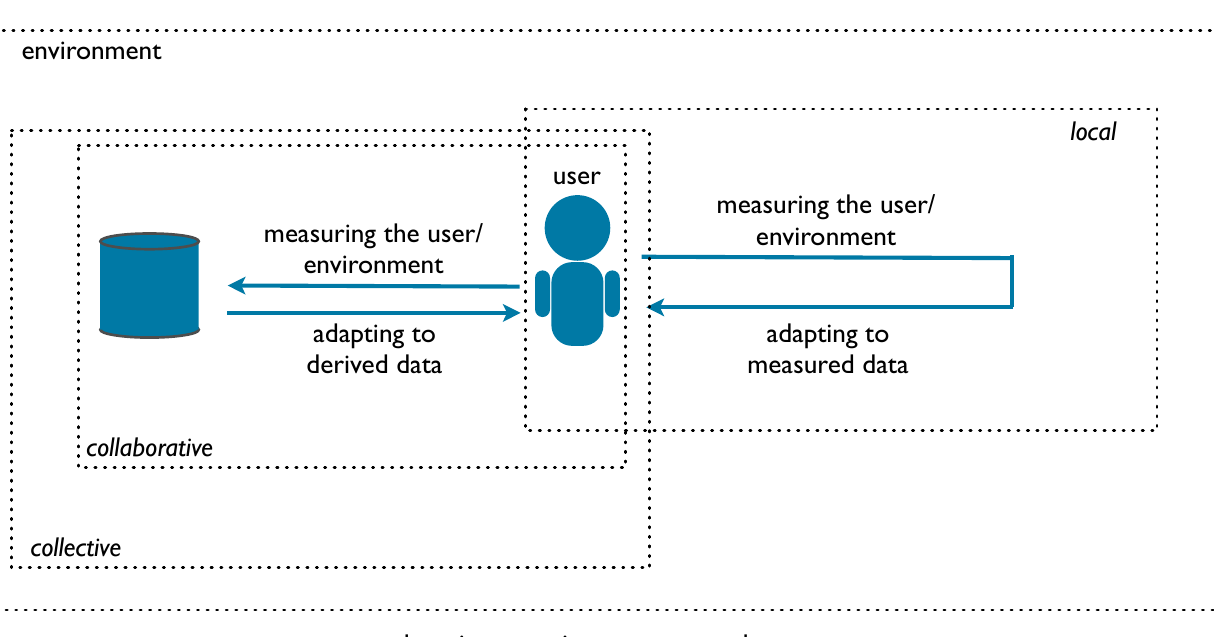
Figure 4. Learning experience augmented with sensor data in three contexts: local, collaborative and collective